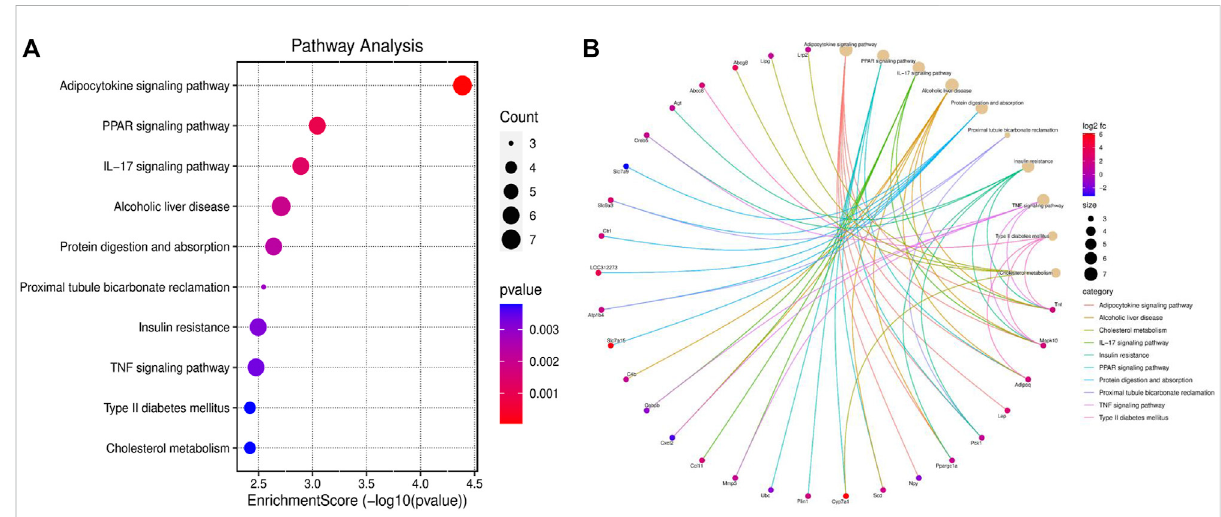
FIGURE 4 KEGG pathway enrichment analysis (top 10). (A) Top 10 signi fi cant KEGG pathways of differentially expressed genes in the T-2 toxin group compared with the control group. (B) Relationship between signi fi cant pathways and enriched genes, and different colors represent different pathways. p -value < 0.05 was considered signi fi cant pathways.